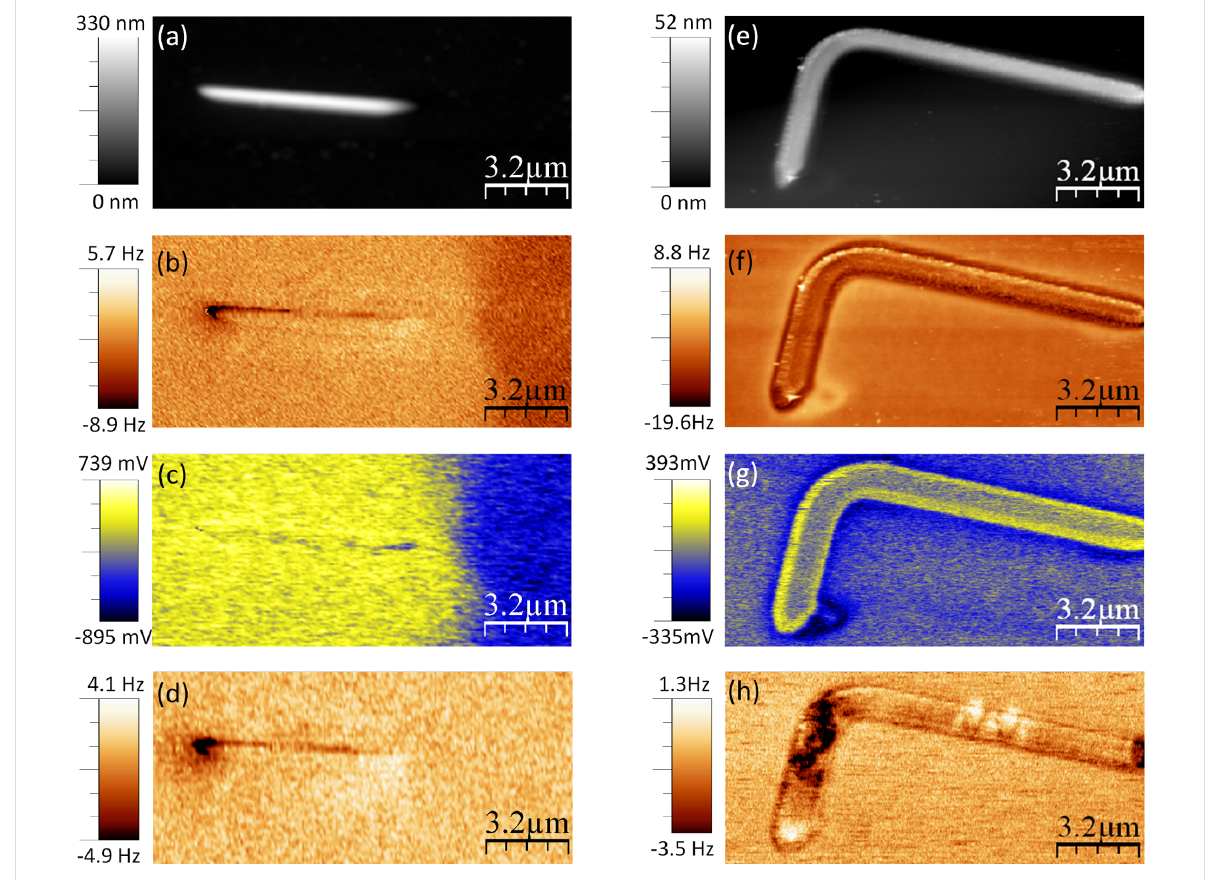
Figure 3: Topography of (a) Co nanowires and (e) L-shaped Co nanostructure. (b) and (f) frequency shift images measured without KPFM acquired at a retrace distance of 30 nm and 25 nm respectively. (c) and (g) surface potential images obtained by the KPFM technique. (d) and (h) MFM images (frequency shift) of the Co nanostructures measured when the KPFM bias correction was switched on. The oscillation amplitudes were (a–d) A = 5 nm and (e–h) A = 8.5